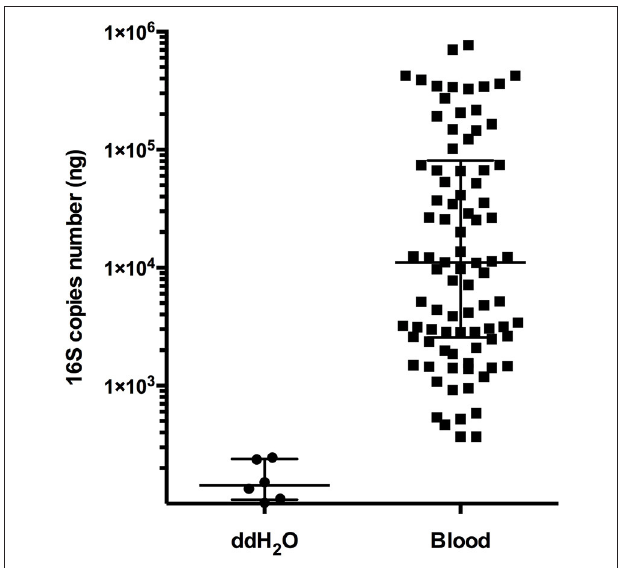
FIGURE S1 | Comparison the 16S gene copies from the no template control and blood samples from 90 individuals by real-time PCR analysis.